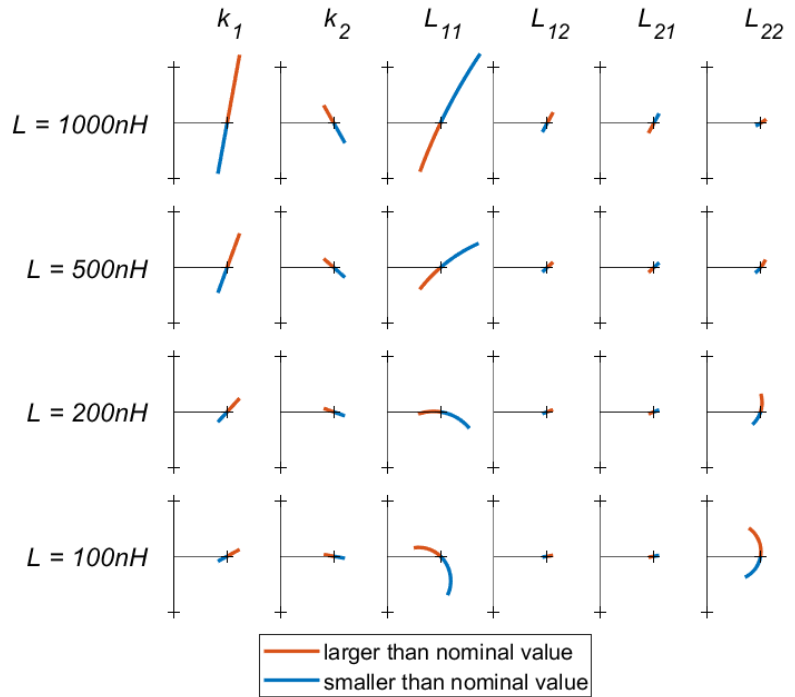
Figure 7. A grid of Nyquist plots showing how the real part (x-axis) and imaginary part (y-axis) of the input impedance of the link change as one of the link parameters ( k 1 , k 2 , and L 11 – L 22 ) is varied from − 10% to +10% of its nominal value. Each column of plots corresponds to a different parameter, whereas the rows indicate different nominal values for L . A longer line indicates a greater sensitivity to the selected parameter. The tick-marks on the axis are placed at a 50 Ω distance from the origin. Each simulation was performed at a frequency of 13.56 MHz with a 50 Ω load and a nominal coupling factor of